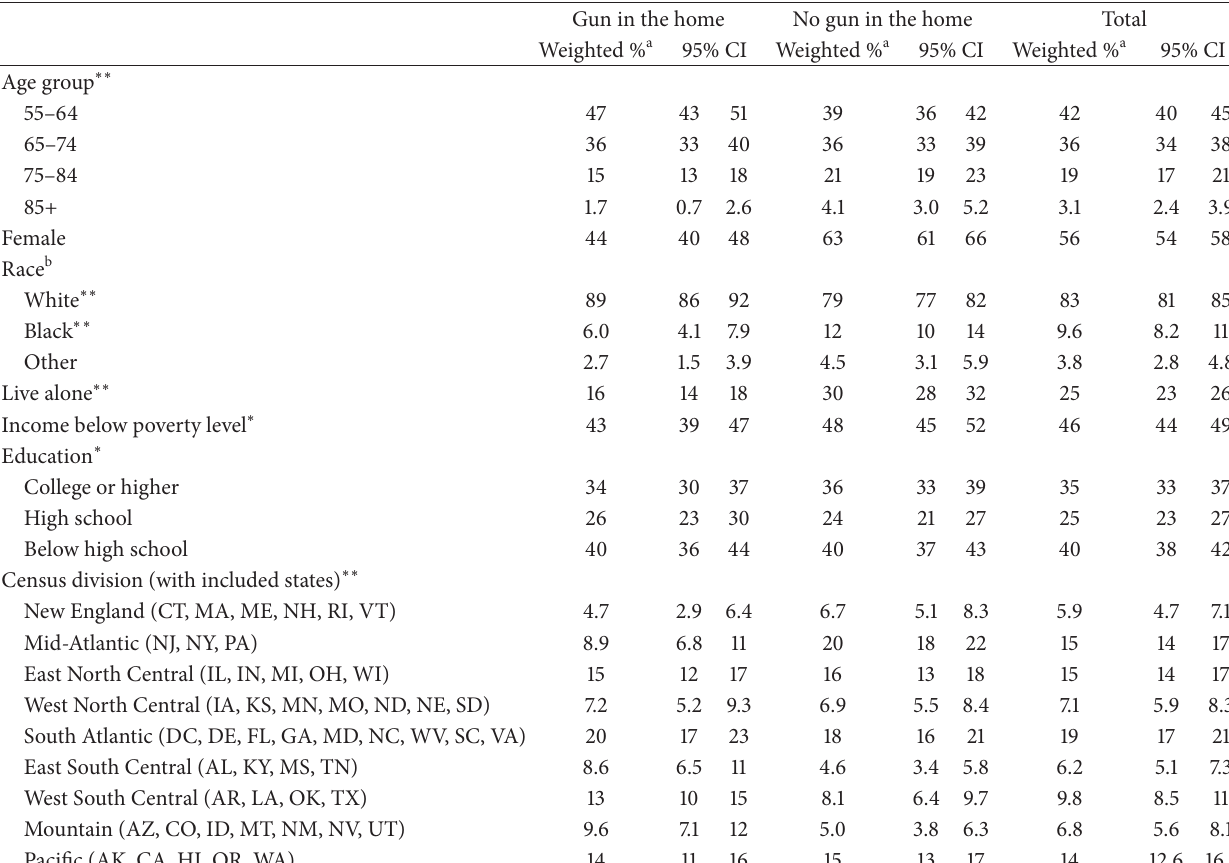
Table 1: Characteristics of older adults by presence of ≥ 1 gun stored in or around the